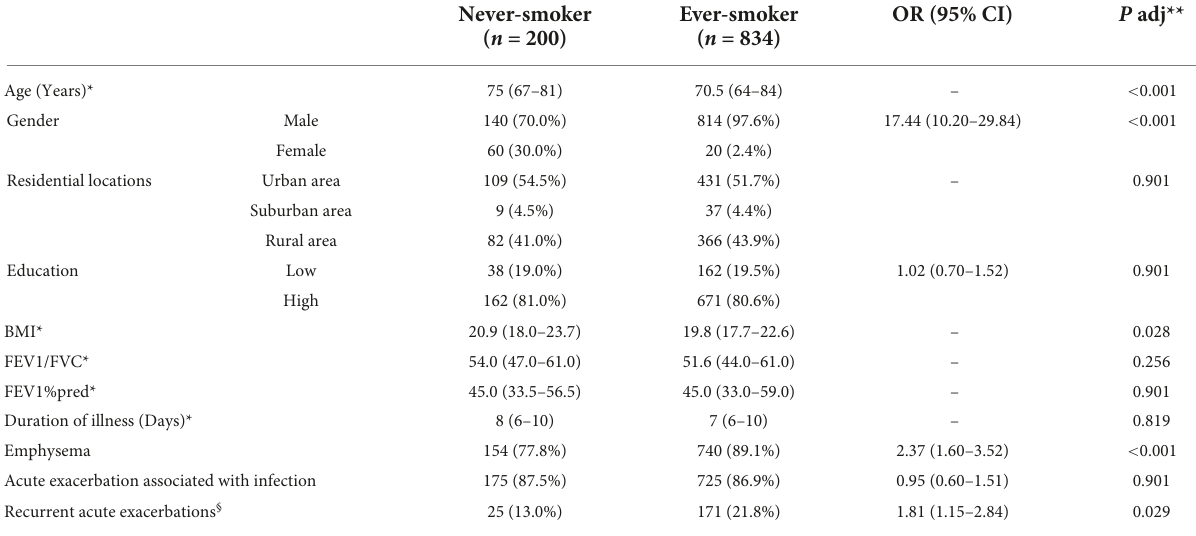
TABLE 2 Association of smoking status with demographic and clinical characteristics in patients with AECOPD.